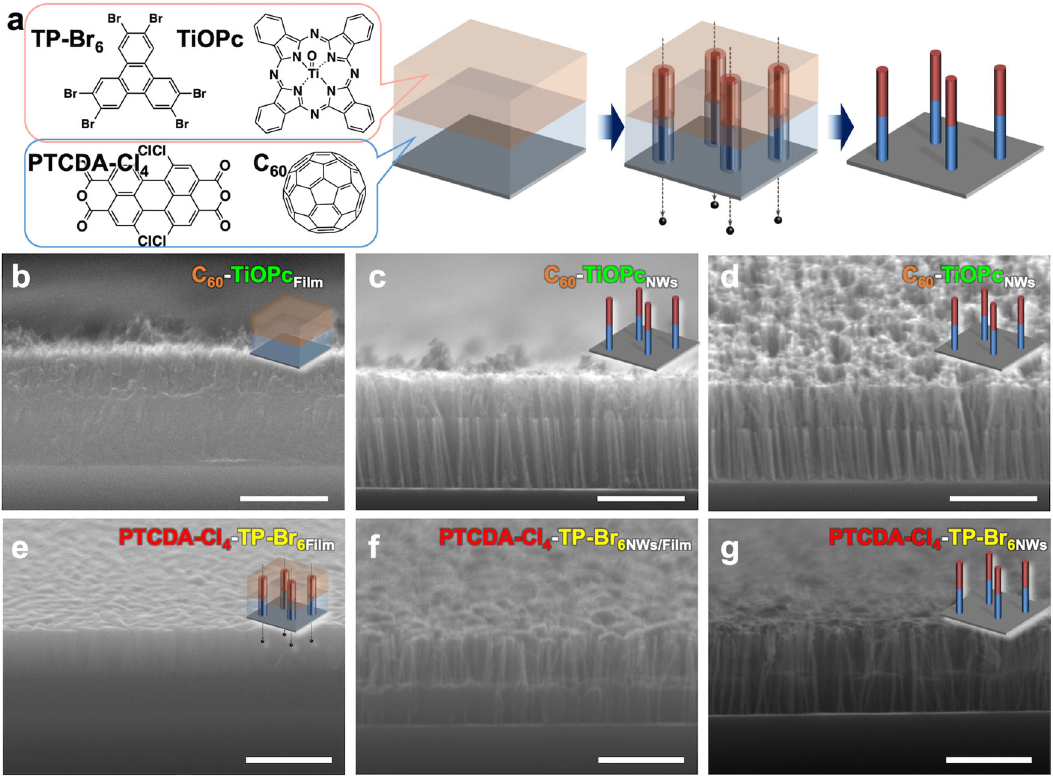
Fig. 5 Block- co -nanowire-type heterointerfaces. a Schematic illustration of fabrication method of free-standing two-segment nanowires from bilayer fi lms. b Side view SEM image of bilayer fi lm of titanyl phthalocyanine (TiOPc) (top) and C 60 (bottom). c Side and d tilt views of two-segment nanowires fabricated via irradiation of TiOPc/C 60 bilayer fi lm with 120 MeV 197 Au 9 + at 1 × 10 11 cm − 2 and subsequent sublimation at ~300 °C. e A SEM image of bilayer fi lm of TP-Br 6 (HBT, top) and PTCDA-Cl 4 (bottom). f , g Tilt views of two-segment nanowires fabricated via irradiation of TP-Br 6 /PTCDA-Cl 4 bilayer fi lm with 120 MeV 197 Au 9 + at 1 × 10 11 cm − 2 and stepwise sublimation at 187 °C for 5 min and 300 °C for 5 min. Scale bars represent 500